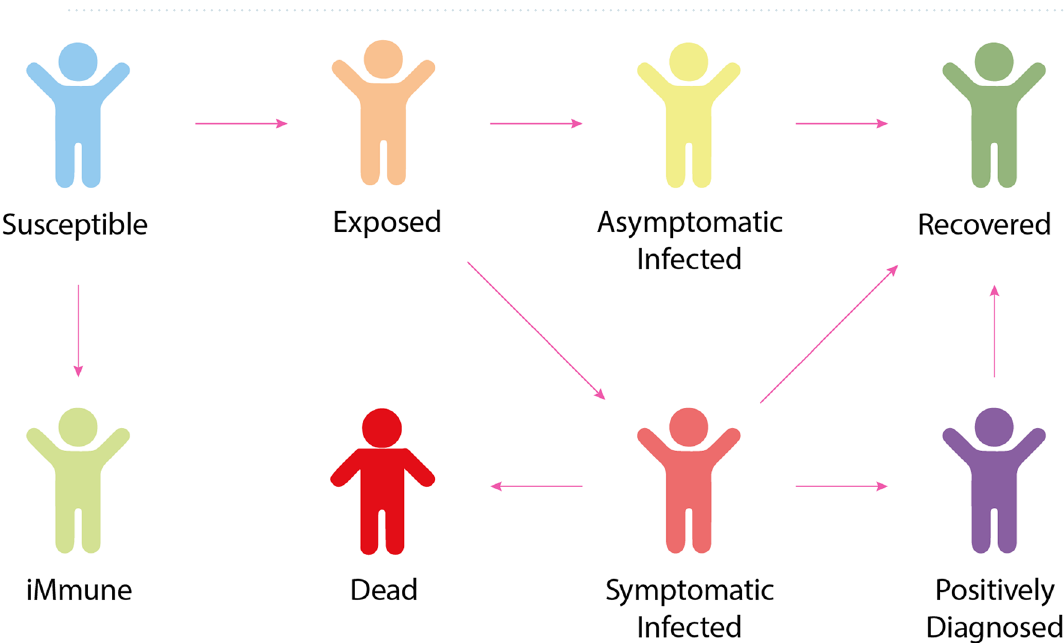
Figure 2. States of agent infection in the SEIAPR-DM model (developed by the